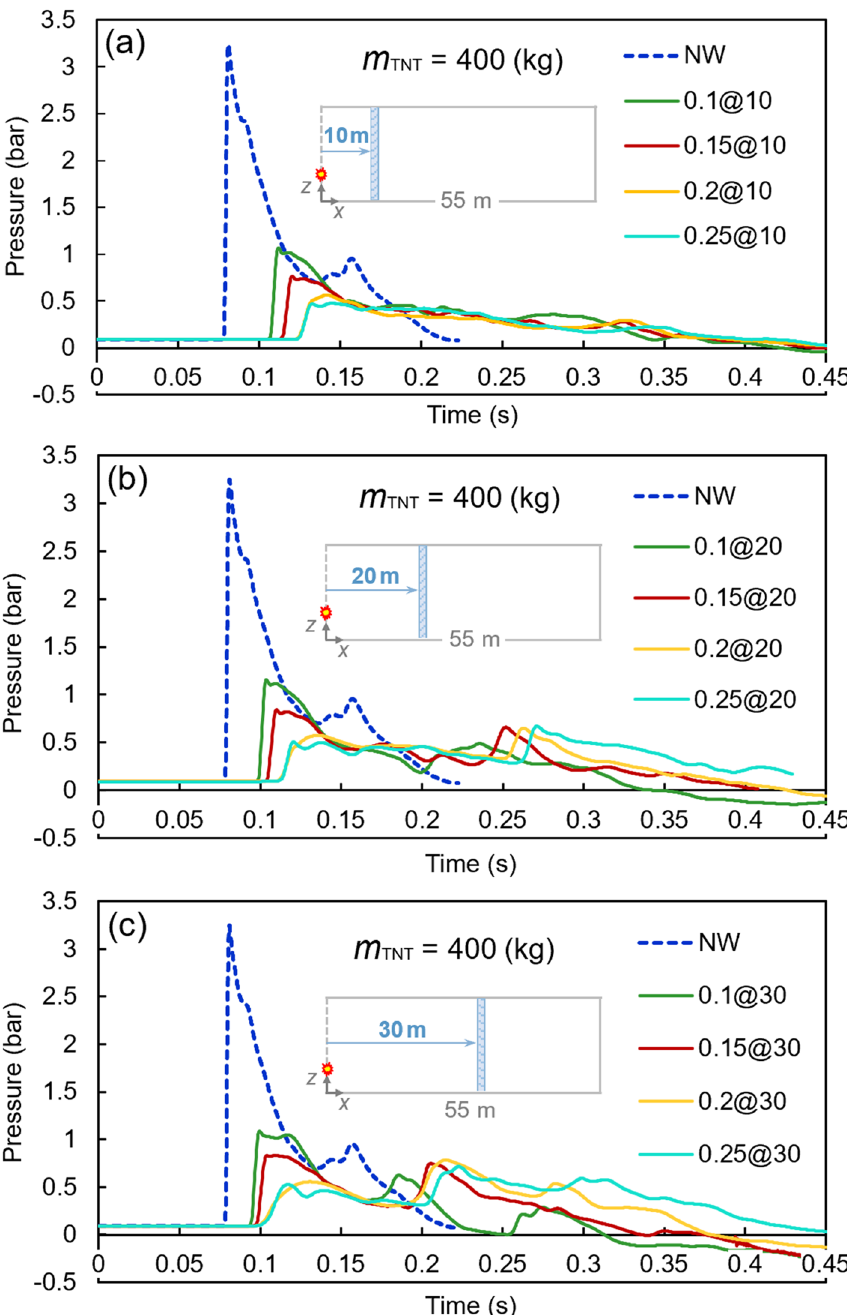
Figure 7. Pressure–time diagrams of the 400-kg TNT charge with different water curtains at various distances: ( a ) 10 m, ( b ) 20 m, and ( c ) 30